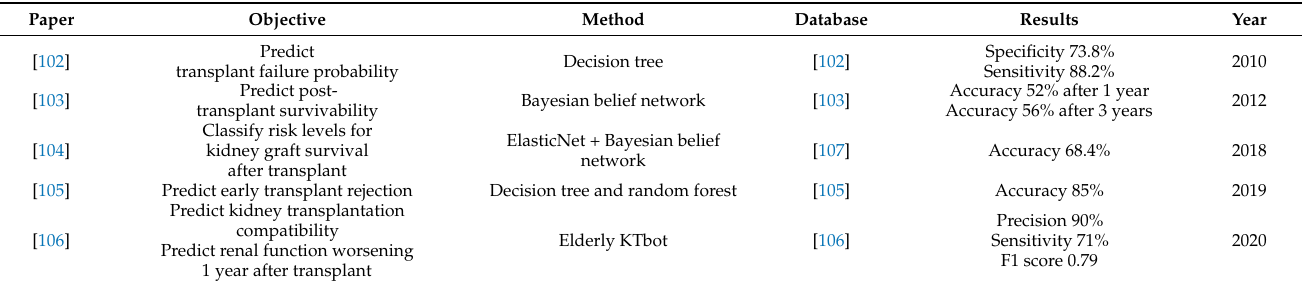
Table 6. Kidney transplant research.